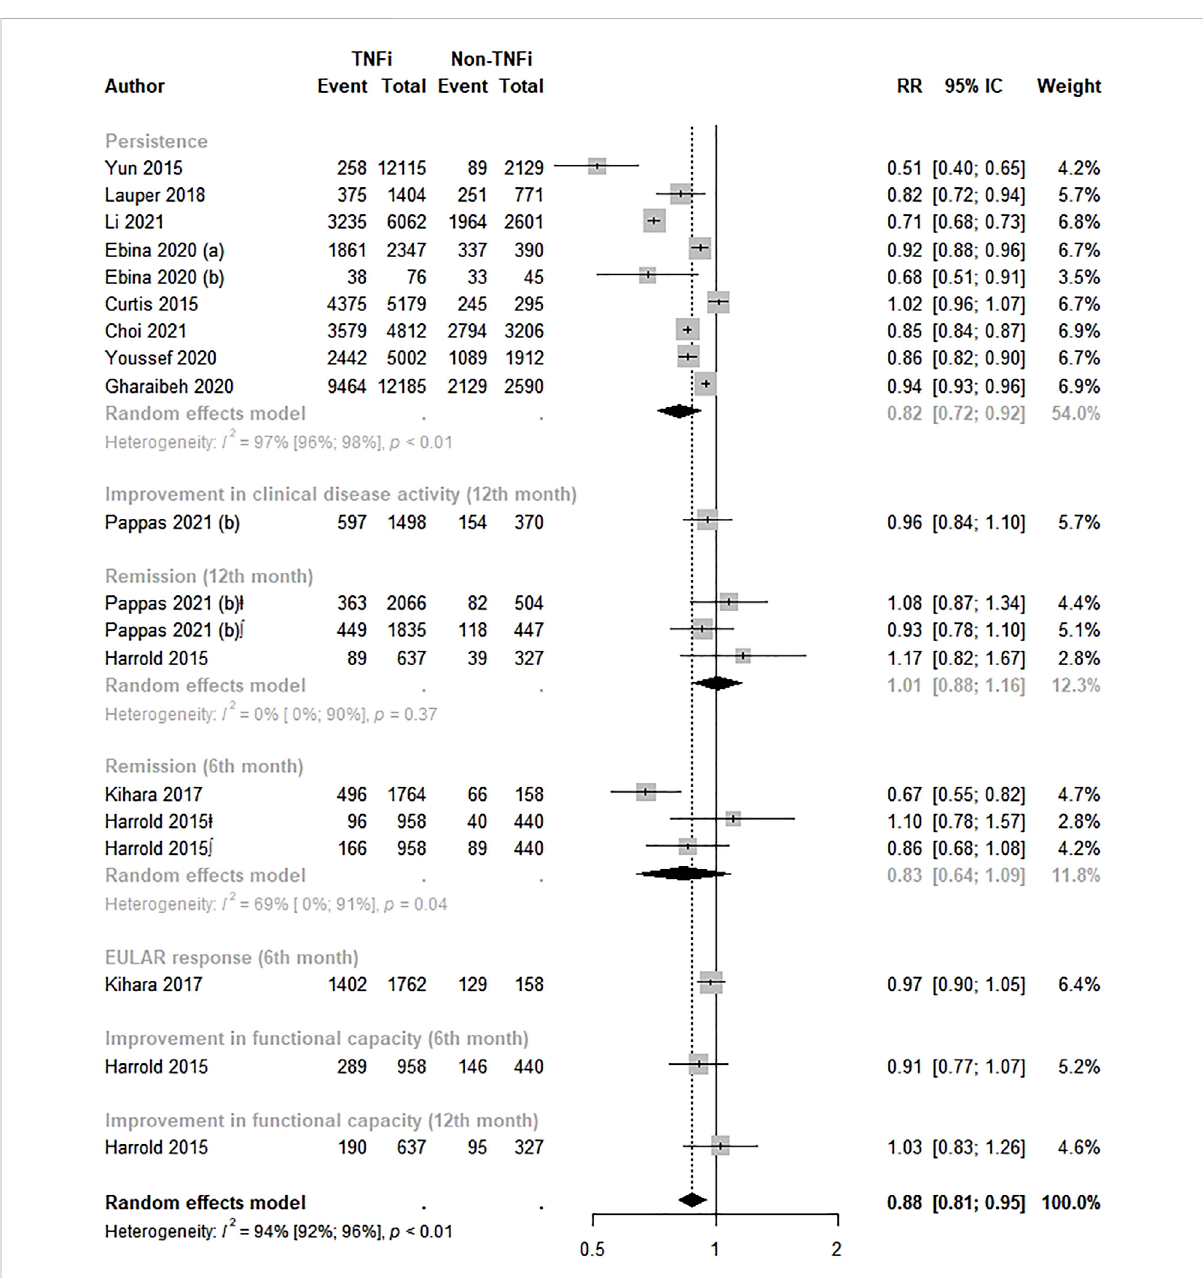
FIGURE 2 EffectivenessofTNFinhibitorscomparedtonon-TNFinhibitors.TNFi,TNFinhibitors;non-TNFi,non-TNFinhibitors; ⱡ ,remissionbasedinCDAI; (cid:1) , remission based in